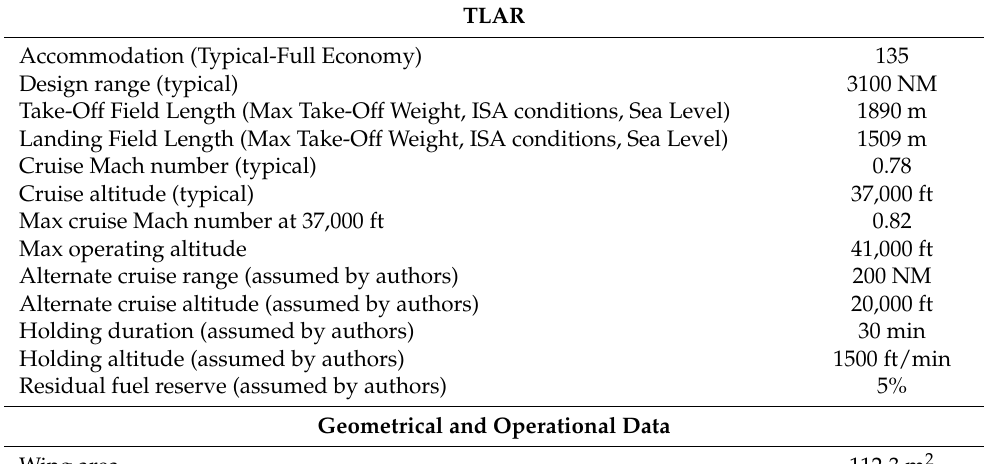
Table 5. Main data concerning the